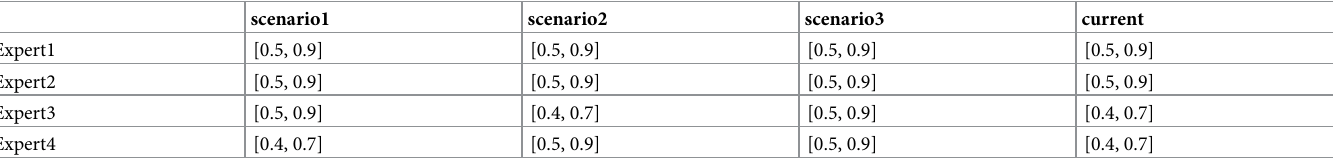
Table 12. Weight assignment for respondents of sensitivity